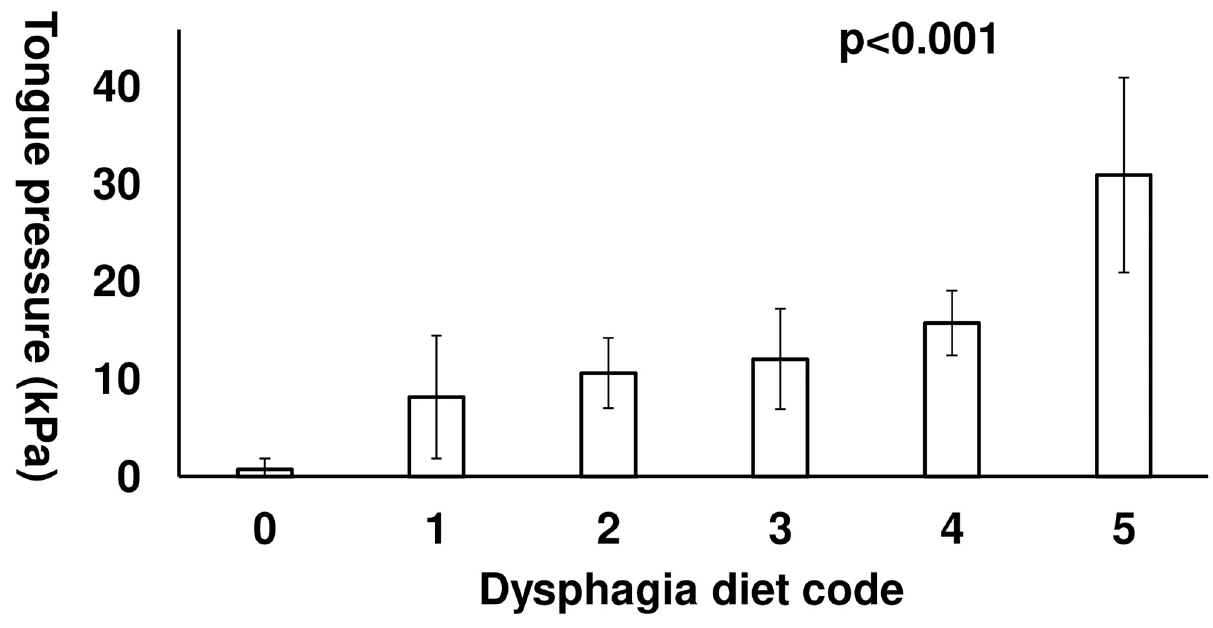
Fig 2. Tongue pressure by dysphagia diet code.